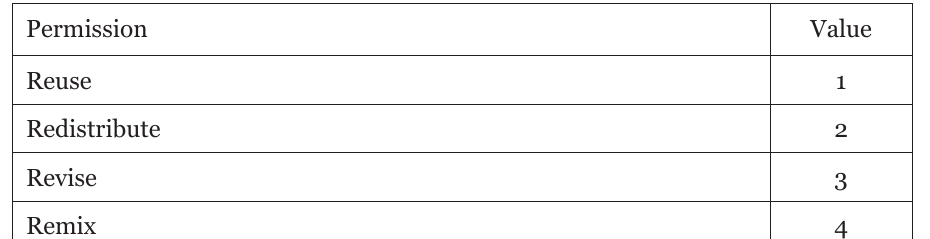
The Level of Openness Based on the Four Rs of Openness Permission Value Reuse 1 Redistribute 2 Revise 3 Remix 4